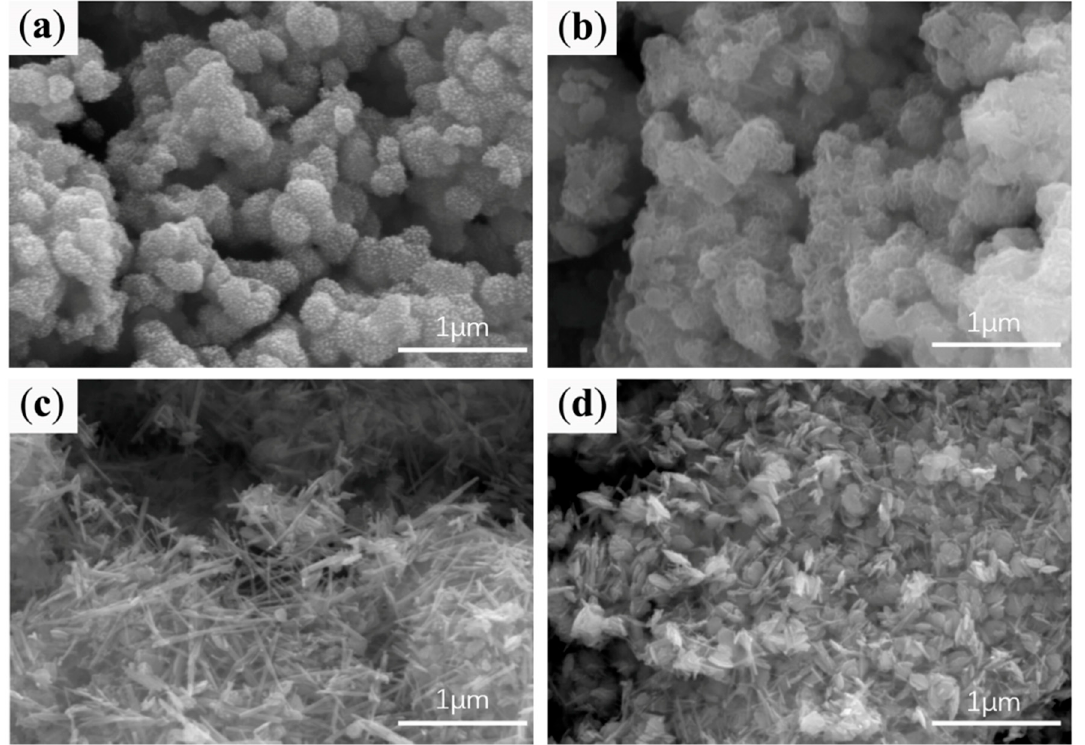
Figure 1. Scanning electron microscope (SEM) images of MnO 2 : ( a ) MnO 2 -40, ( b ) MnO 2 -50, ( c ) MnO 2 -60, ( d ) MnO 2 -70.